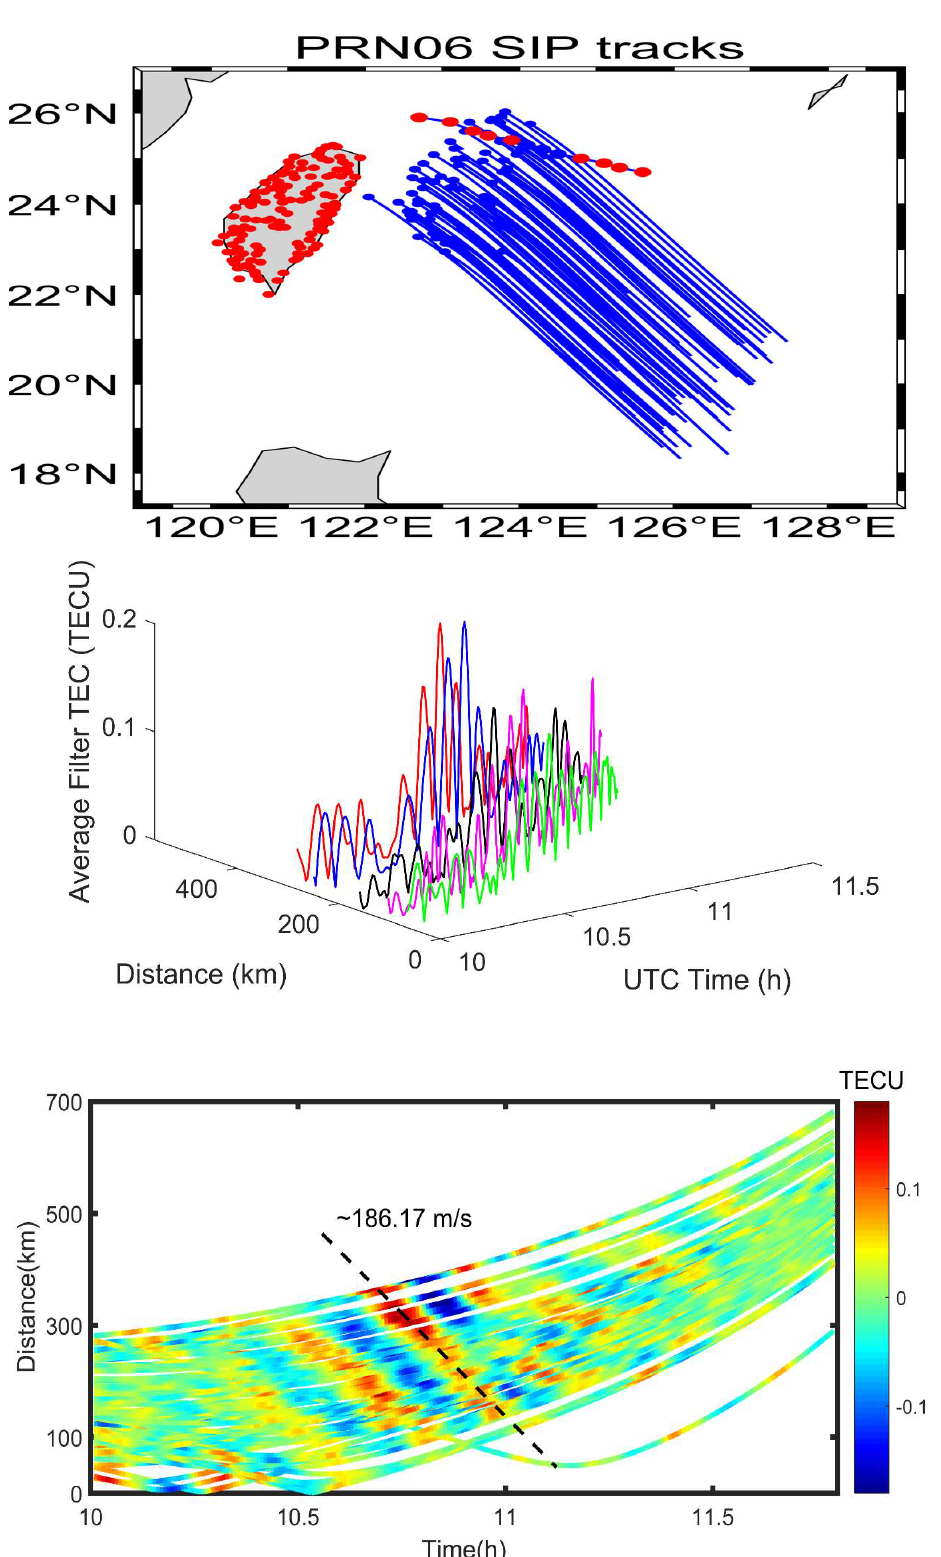
Figure 8. Detailed features of the ionospheric disturbances detected by PRN06 when Typhoon Maria passed the eastern sea area of Taiwan on July 10, 2018. The top panel shows the SIP tracks of all stations from 10:00-12:00 UTC. The middle panel shows a graph of the average filtered TEC and distance, and the bottom panel shows a graph of the filtered TEC time series with the time.